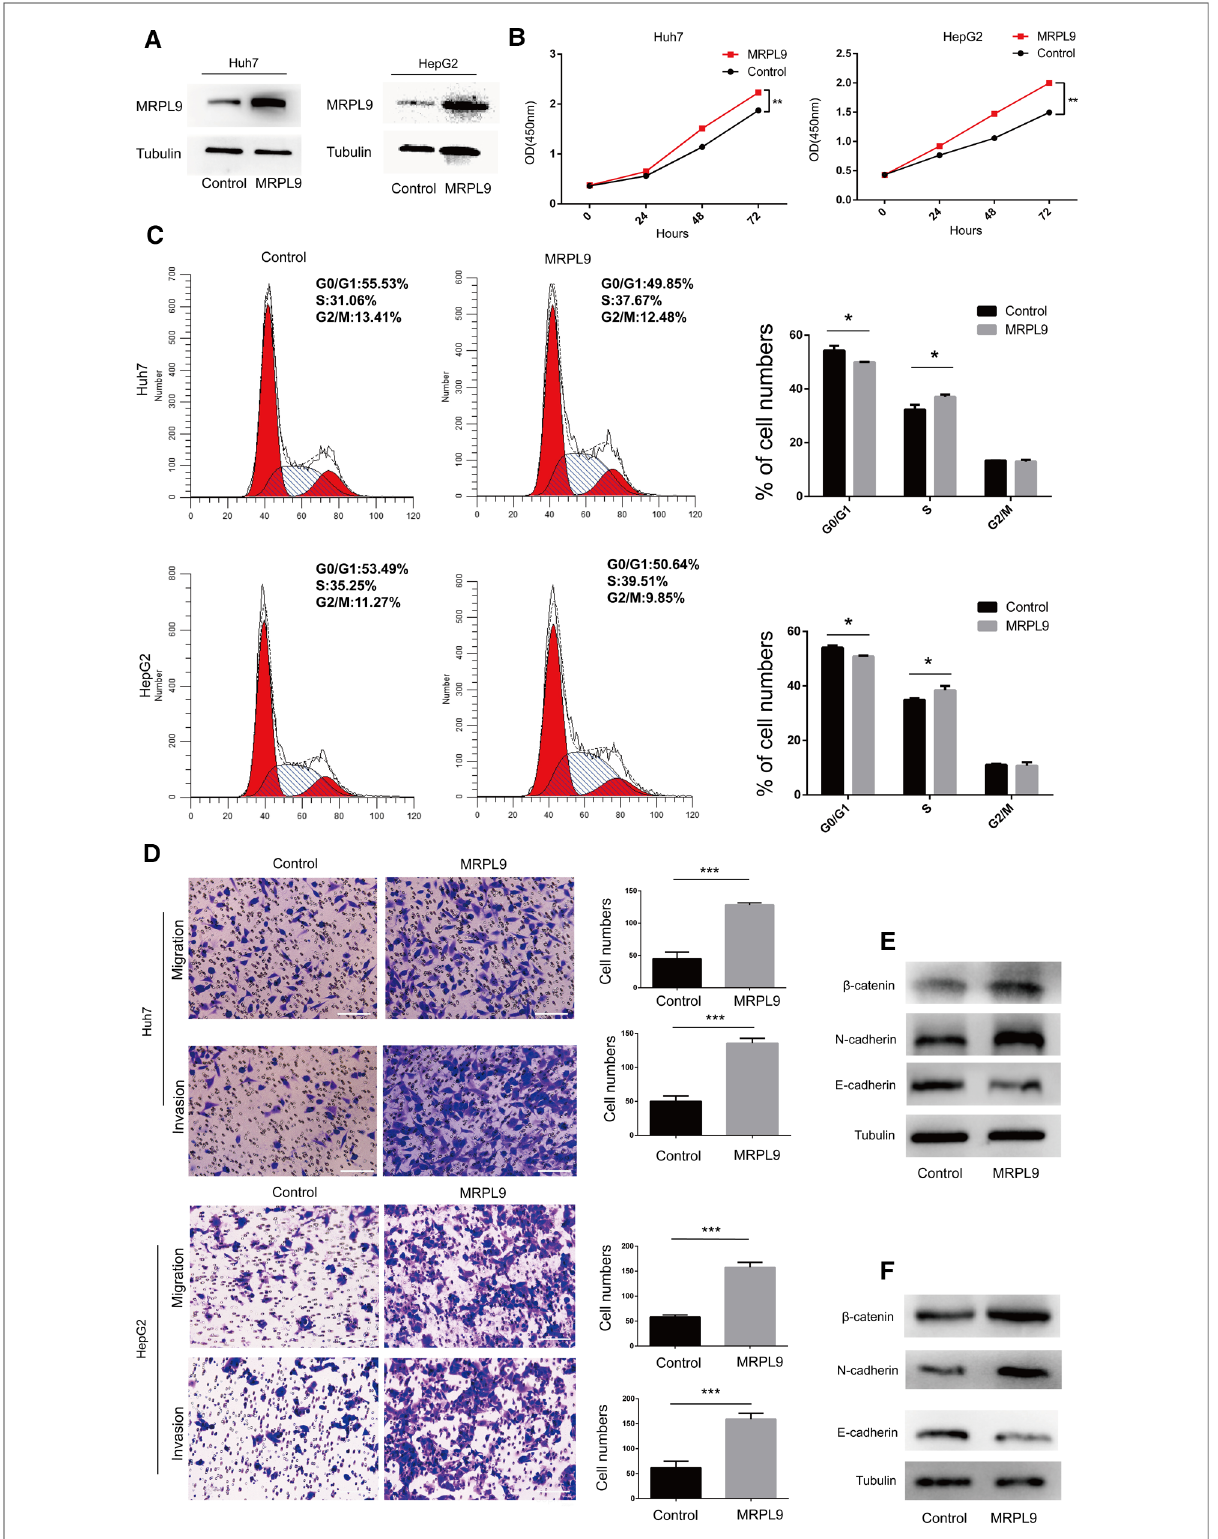
FIGURE 9 Overexpressed MRPL9 promotes liver cancer cell proliferation, migration, and invasion progression. ( A ) Overexpressed MRPL9 was veri fi ed by western blot in Huh7 and HepG2 cells. ( B ) MRPL9 promotes the ability of proliferation in Huh7 and HepG2 cells. ( C ) Flow cytometry indicated that overexpressed MRPL9 promoted the transition of the cell cycle of Huh7 and HepG2 cells. ( D ) Overexpressed MRPL9 promoted the migration and invasion of Huh7 and HepG2 cells. Scale bar=100 µm. ( E,F ) Western blot revealed that MRPL9 could promote the process of EMT in Huh7 and HepG2 cells,